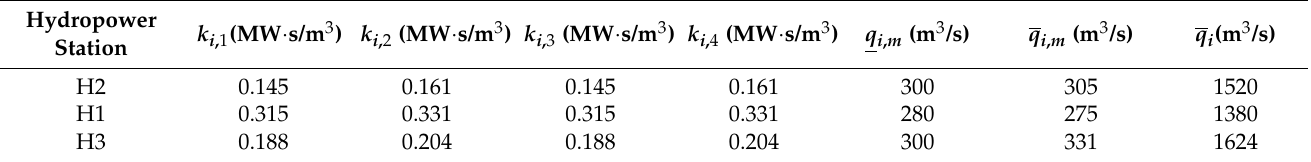
Table A2. Parameters of hydropower stations.